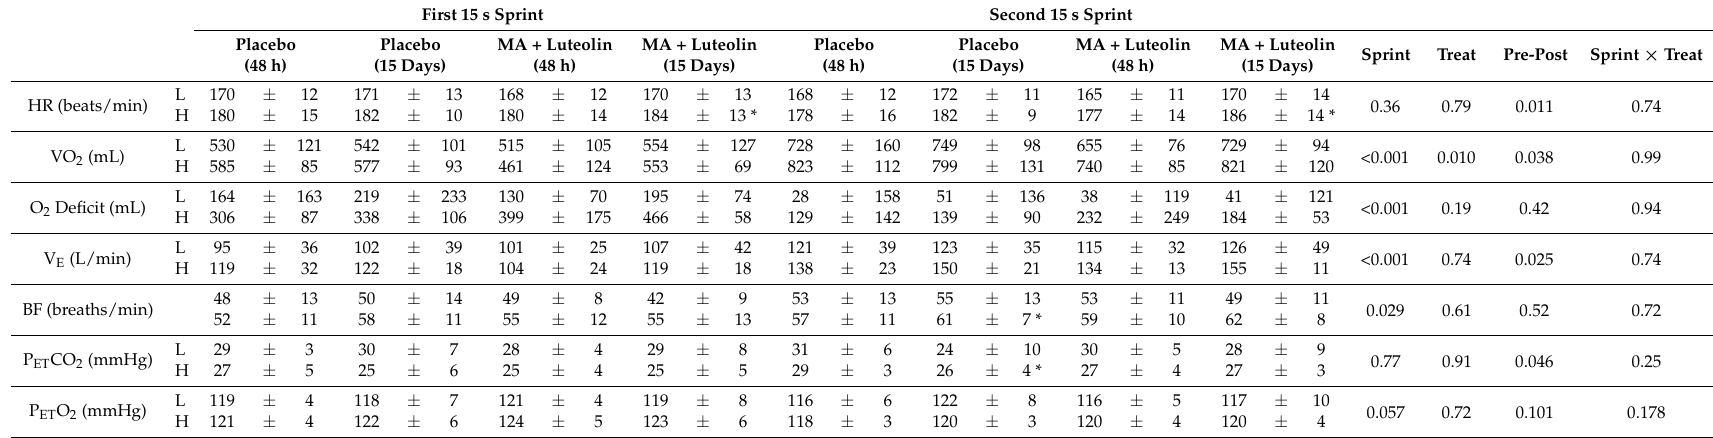
Table 2. Effects of mangiferin and luteolin botanical extracts on heart rate and pulmonary gas exchange during 15 s all-out sprint performed after ischemia/reperfusion, immediately after the incremental exercise to